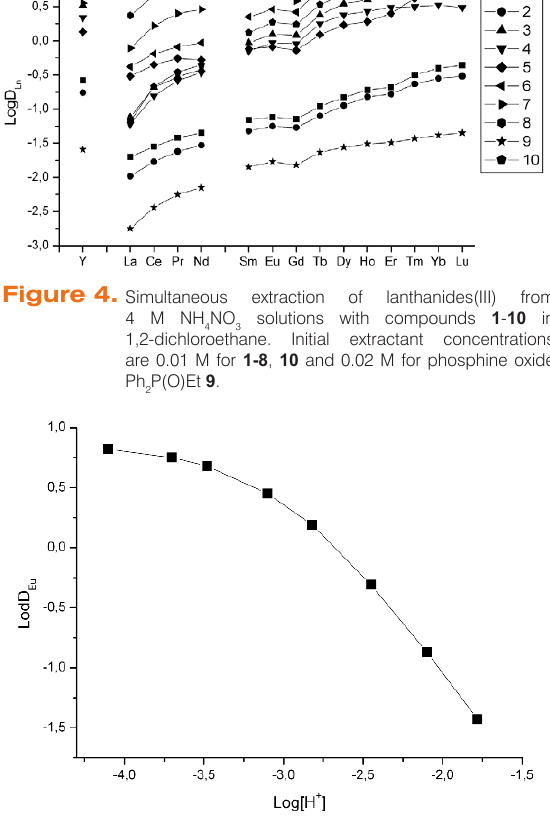
Figure 5. Influence of the equilibrium concentration of H + ions in the aqueous phase on the extraction of Eu(III) using 0.025 M solution of compound 3 in 1,2-dichloroethane from 4 M NH NO 4 3